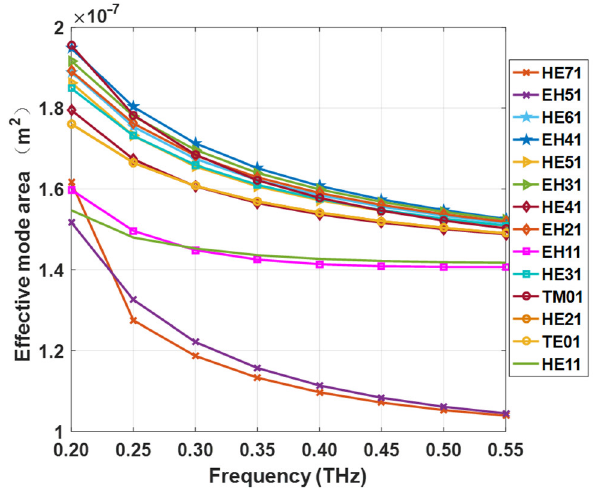
Figure 10. Effective mode area as a function of frequency for different modes.